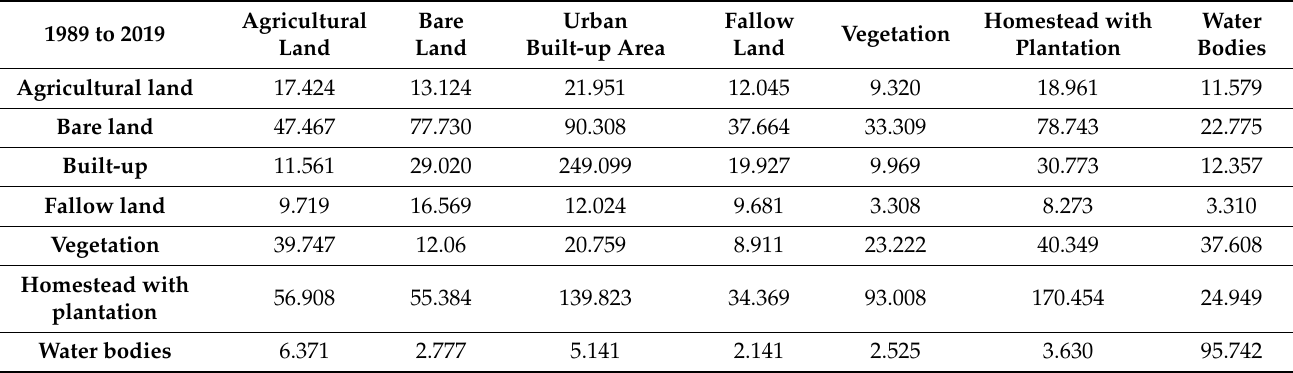
Table 13. Transition matrix (1989 to 2019).